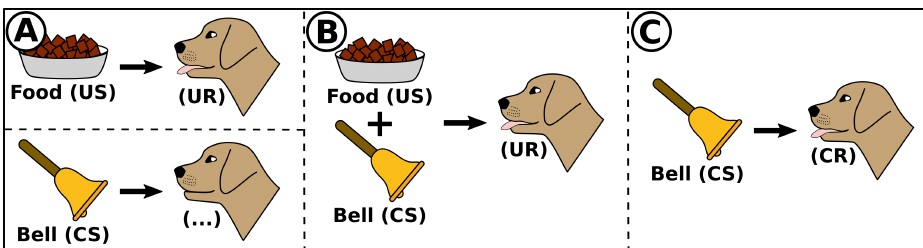
Figure 1. Summary of the different phases of the Pavlov conditioning experiment with a dog. ( A ) Initially, the dog is untrained and, when presented the conditional stimulus (CS, the bell ring), it shows no reaction. When presented the unconditional stimulus (US, food), it starts to salivate by anticipation (UR, the unconditional response). ( B ) In the training phase of the experiment, the dog is presented food and at the same time it hears the bell ring (US + CS training). ( C ) In the testing phase, no food is presented to the dog, but the bell ring alone triggers its salivation (CR, conditioned response). Hence, with training, the dog learns to associate the two stimuli together and eventually reacts positively to the bell ring even in the absence of